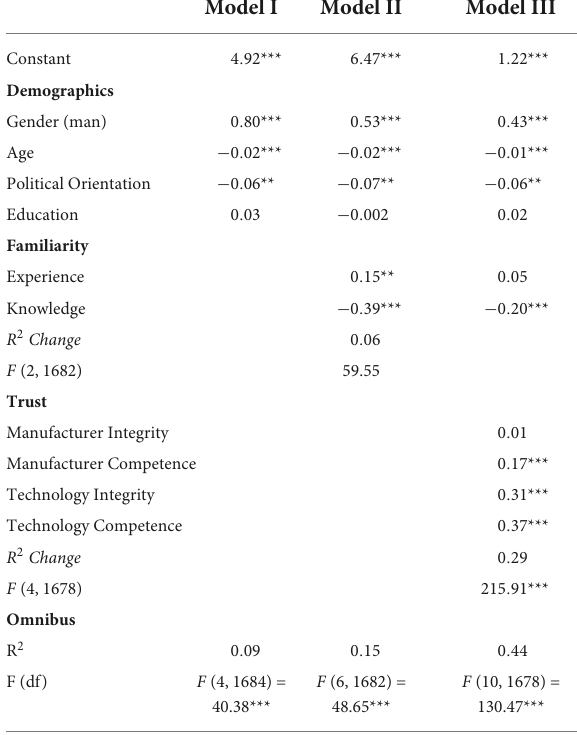
TABLE 3 Study 2a [autonomous vehicle (AV) domain] regression models predicting adoption